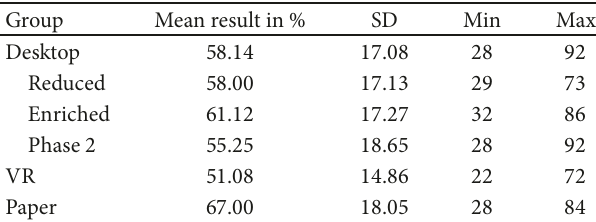
Table 2: Test results in the AT knowledge assessment